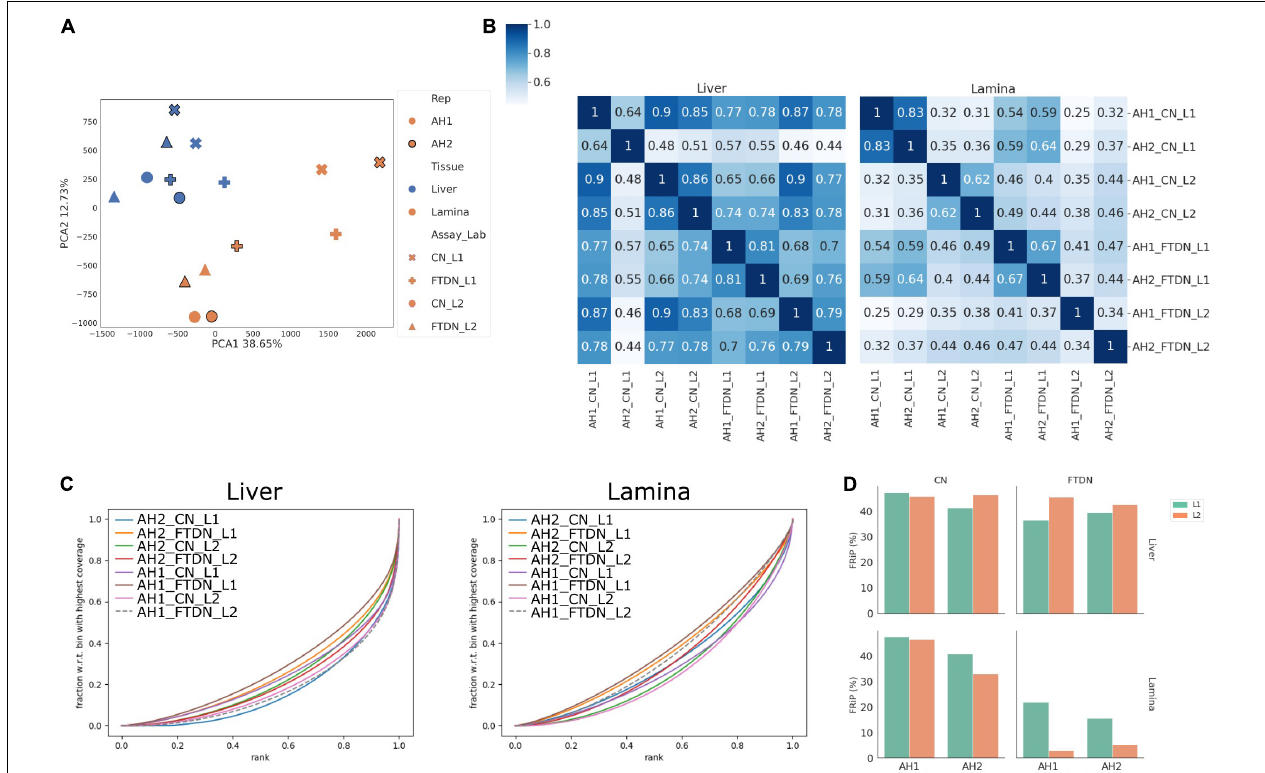
FIGURE 2 | Read coverage correlation between libraries. Read depth was normalized across all libraries. (A) Principal component analysis of genome coverage, showing the first two principal components. (B) Pearson correlation of genome coverage in liver (left) and lamina (right) libraries. Linkage was calculated using Farthest Point Algorithm. (C) Fingerprint plot of genome coverage in liver (left) and lamina (right) libraries. (D) Enrichment as measured by FRiP in each